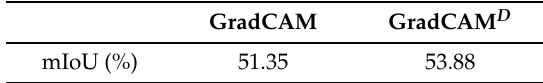
Table 2. Evaluating the effectiveness of GradCAM D proposals on iSAID validation set. GradCAM: Standard GradCAM proposals within bounding